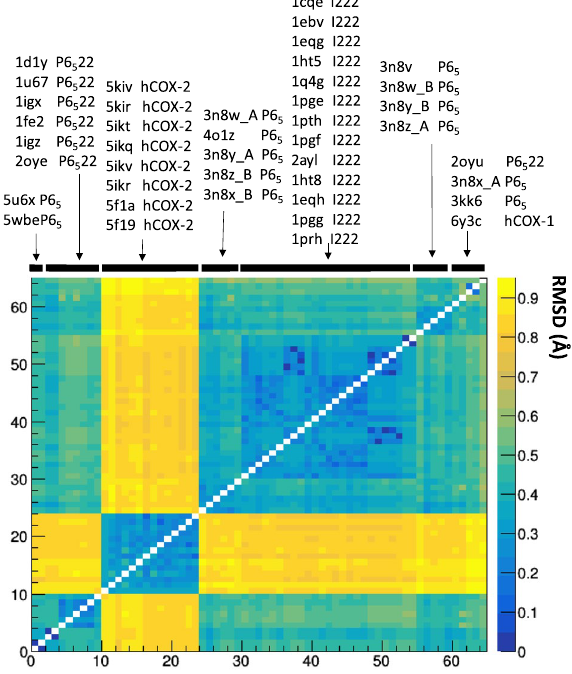
Figure 6. Matrix of the Cα pairwise RMSD values calculated between individual chains of the 37 structures of h COX-1, o COX-1, and h COX-2 present in the PDB. Chains are ordered based on a hierarchical clustering algorithm having RMSD as distance metrics. They are labelled on the top by using the PDB code, the type ( h COX-1 or h COX-2), the space group (only for o COX-1), and the chain letter (A or B are reported only if they do not fall in the same